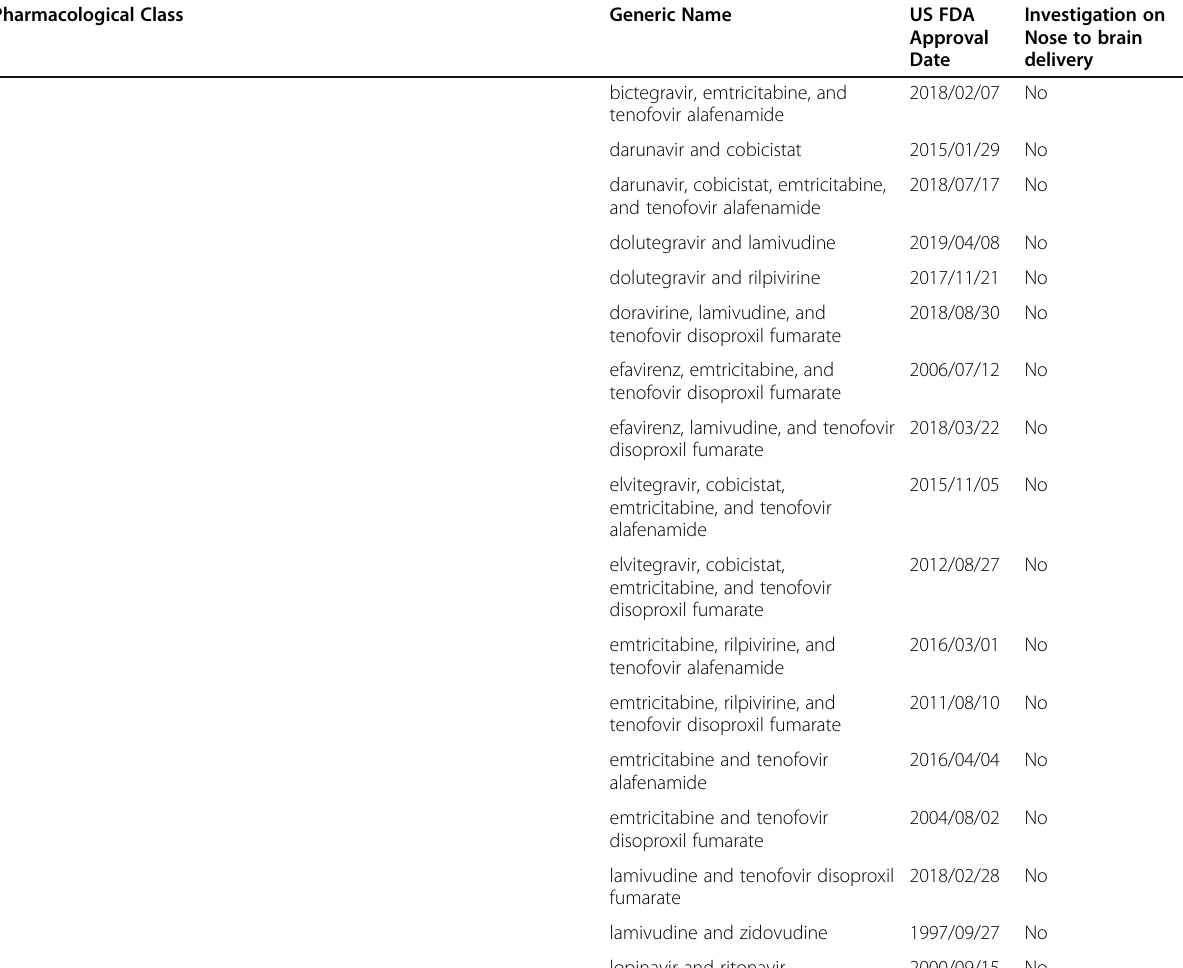
Table 1 US FDA approved antiretroviral drugs and status of their nose to brain delivery (Continued) Pharmacological